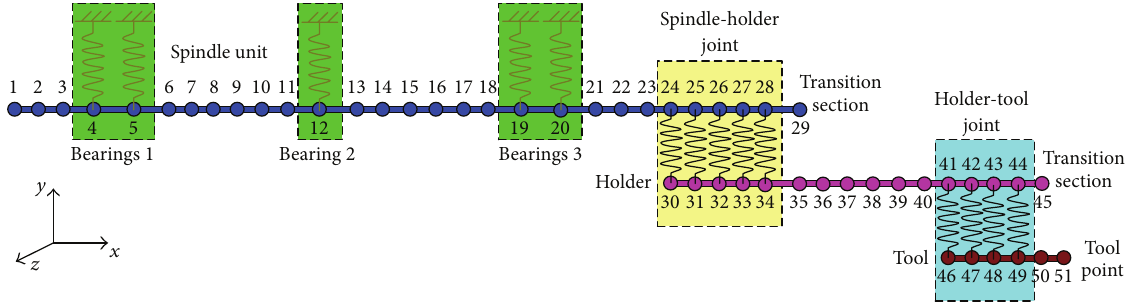
Figure 8: The model of high-speed spindle system.